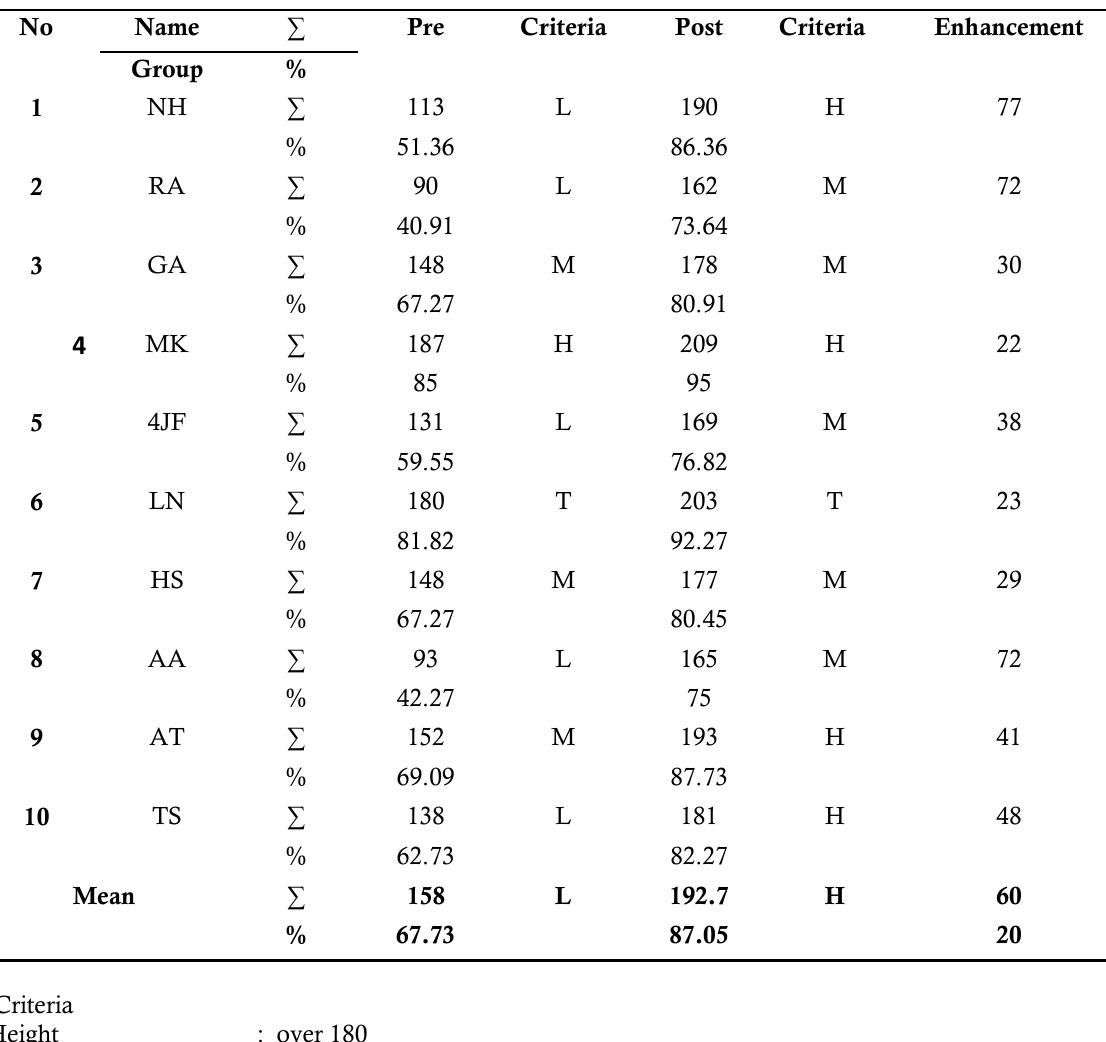
Tabel 1.2 Acquisition Total Score Initial Evaluation and Final Evaluation